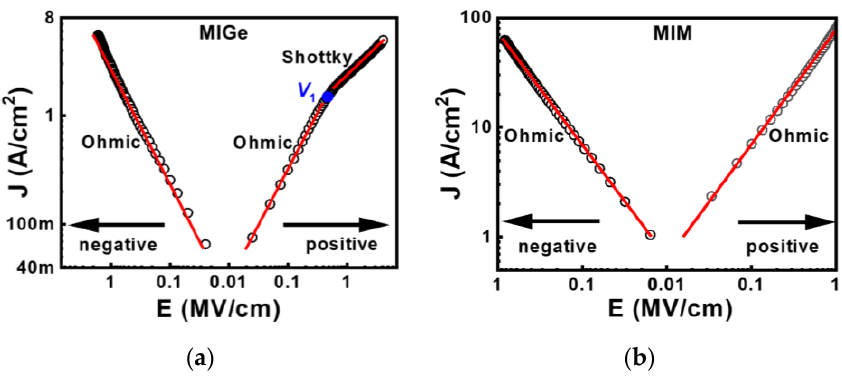
Figure 4. J - E curves of ( a ) Pd/HfO x /p-Ge devices and ( b ) TiN/HfO x /Pt devices in low resistance state.